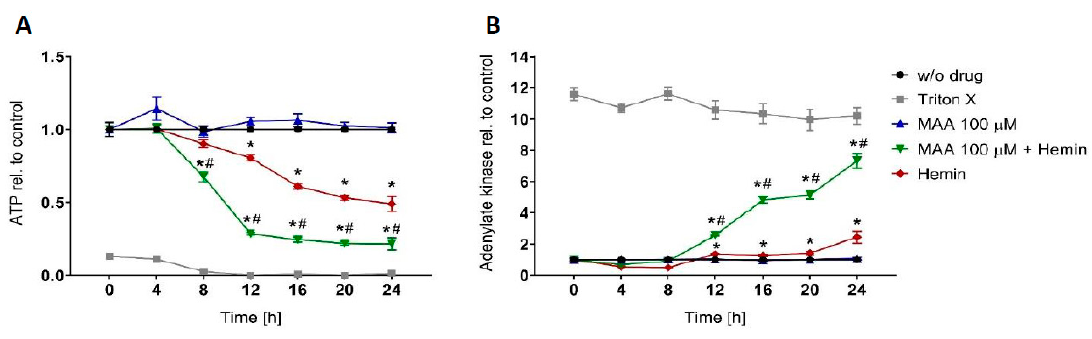
Figure 1. Time dependency of the effect N-methyl-aminoantipyrine (MAA) and/or hemin on the ATP content and plasma membrane intactness of HL60 cells. HL60 cells were treated with the toxicants for 24 h. ( A ) Cellular ATP content determined using the CellTiter-Glo ® luminescent assay. ( B ) Intactness of the plasma membrane of HL60 cells determined by the release of adenylate kinase into the supernatant. n = 3 independent experiments in triplicate presented as the mean ± SEM. * p < 0.05 vs. value at time 0 h. # p < 0.05 vs. the corresponding value of incubations with hemin only.